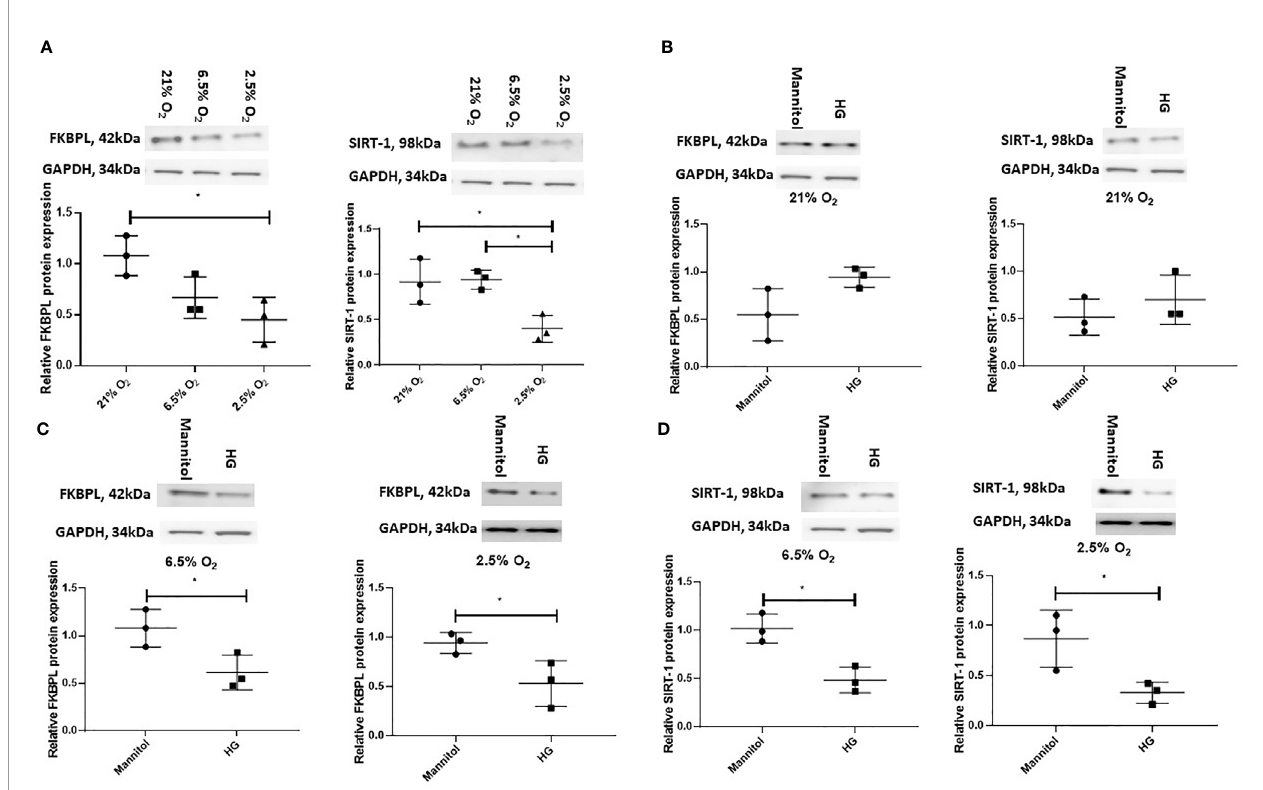
FIGURE 4 | FKBPL and SIRT-1 protein expression is reduced in ACH-3P cells in high glucose conditions in the presence of low oxygen levels. ACH-3P cells were exposed to high glucose HG, (25mM) in the presence of varying oxygen (O 2 ) conditions for 24 h before protein was extracted and Western Blotting performed. (A) FKBPL and SIRT-1 protein expression is reduced by low oxygen (2.5%) conditions at normal glucose concentration. (B) FKBPL and SIRT-1 protein expression remained unchanged in normal experimental oxygen conditions in the presence of high glucose compared to normal glucose. (C) FKBPL and (D) SIRT-1 protein expression was reduced in high glucose conditions at 6.5% and 2.5% O 2 compared to normal glucose conditions at the same oxygen levels. Protein expression was normalised to GAPDH. (n=3, (A) one-way ANOVA with Bonferroni post-hoc test ’ (B – D) unpaired t-test,